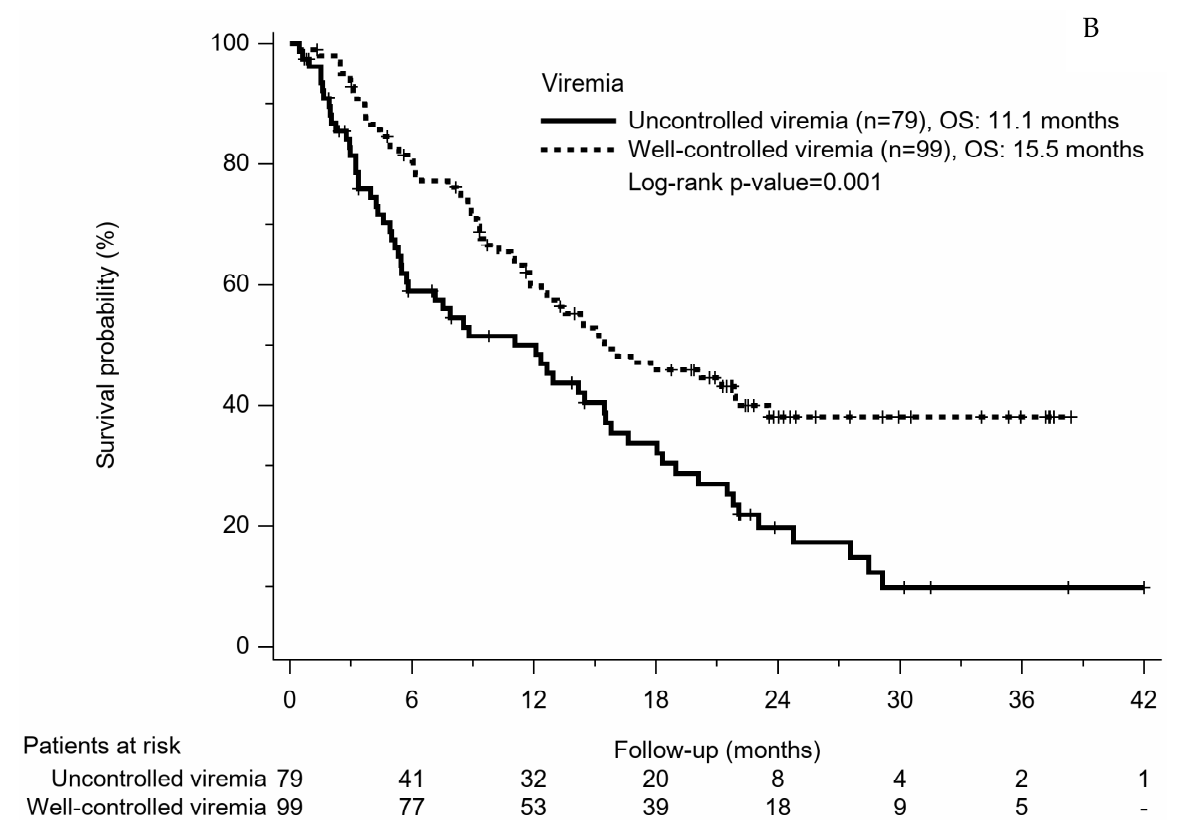
Figure 3. ( A ). Progression-free survival rates of patients with well-controlled viremia and uncon- trolled viremia. ( B ). Overall survival rates of patients with well-controlled viremia and uncontrolled viremia.